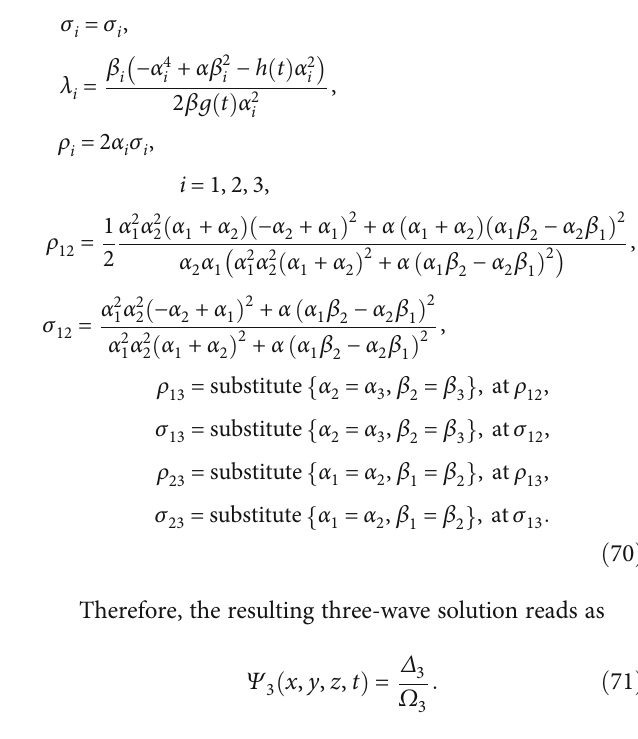
Figure 15: The three-wave solution (71) at α = 0 : 5, β = 0 : 2, α = 3, g ð t Þ = sin ð t Þ , h ð t Þ = cos ð t Þ , and y = 1 2 : 2, ρ 2